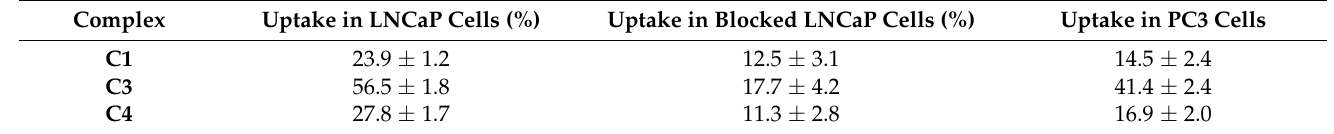
Table 6. Comparison of the uptakes of 99m Tc complexes at 1 h incubation in AR-positive cells (with and without blocking) and AR-negative cells. Values are expressed as means ± SD, n = 3. Complex Uptake in LNCaP Cells (%) Uptake in Blocked LNCaP Cells (%) Uptake in PC3 Cells